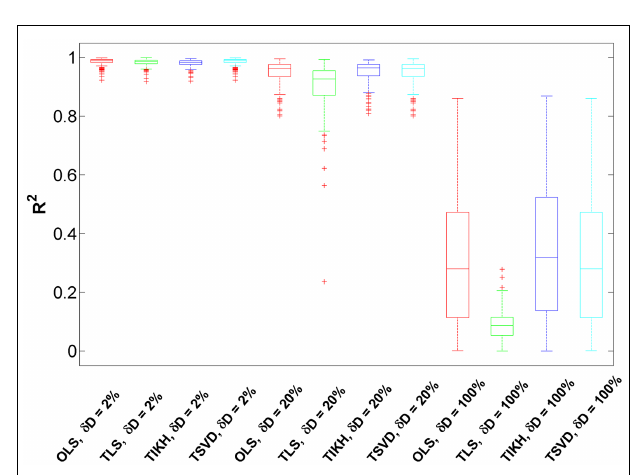
FIGURE 4 | The goodness of the reverse Jacobian for the Sucrose PGM model calculated from four methods under three levels of fluctuation matrix perturbations is represented as R 2 when regressed to the true Jacobian (vectorized, see Introduction) . The perturbation is represented as relative change δ D with three levels, 2, 20, and 100%. The four reverse calculation methods are OLS, ordinary least squares; TLS, total least squares; TIKH, Tikhonov regularization; and TSVD, truncated singular value decomposition. Each boxplot shows the distribution of R 2 over 100